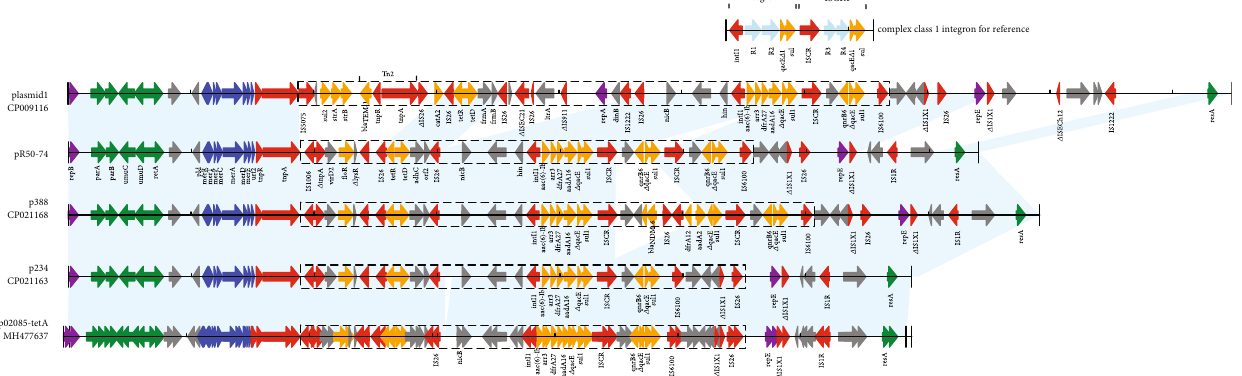
Figure 4: Comparative analysis of the genome structures of pR50-74, plasmid1, p388, p234, and p02085-tetA. Genes are denoted by arrows. Genes, mobile elements, and other features are colored based on functional classi fi cation. Shading denotes homologous regions ( > 95% nucleotide identity).